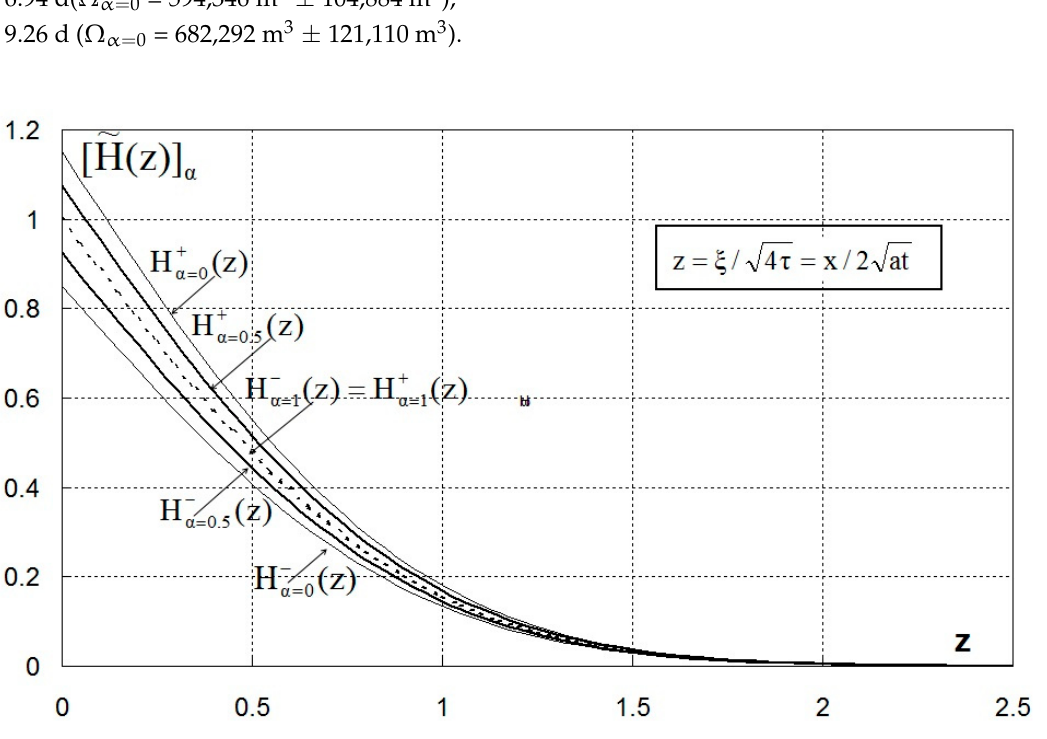
Figure 8. Dimensionless depth profiles as a function of ξ , for times t = 0.25 d and 4 d and for α = 0, 0.5, and 1.